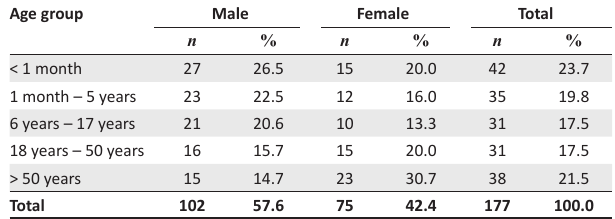
TABLE 1: Age distribution of bloodstream infection study participants in relation to gender at the Federal Teaching Hospital, Ido-Ekiti, Nigeria, between June